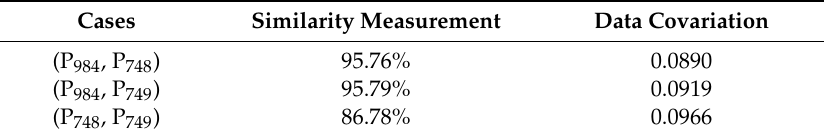
Figure 7. Data visualization of past cases 984, 748 and 749 after normalization.